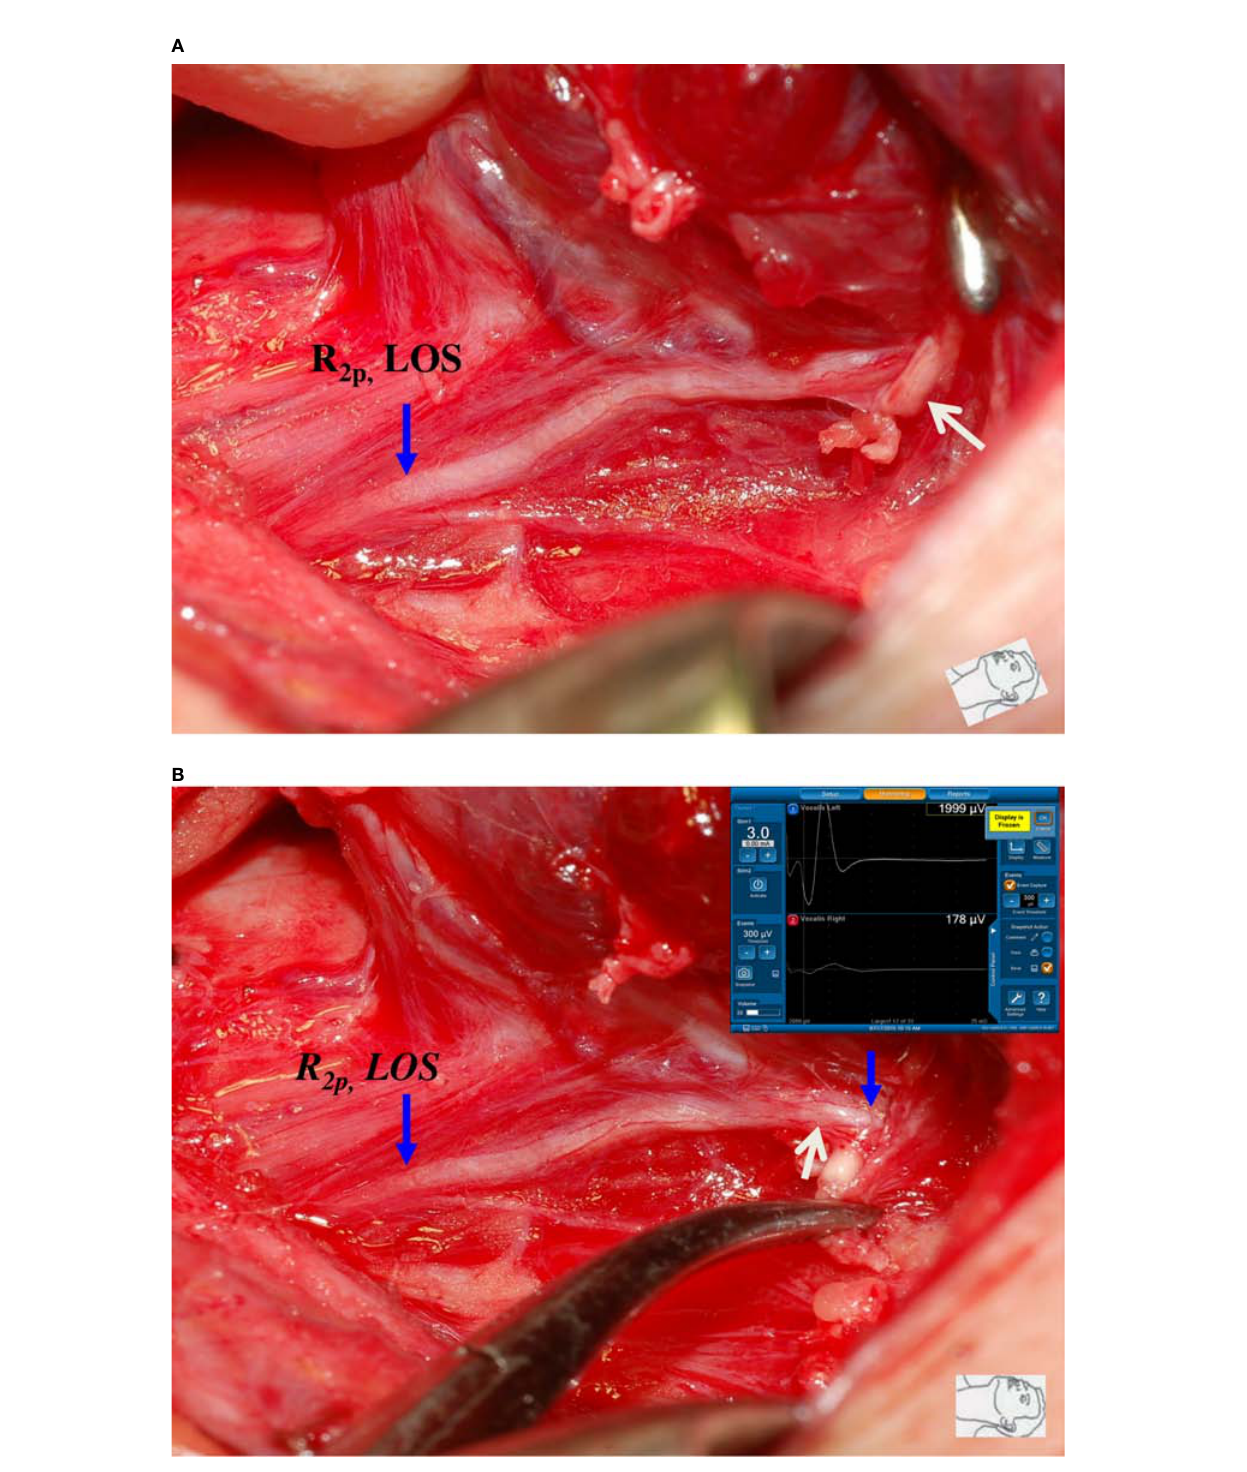
FIGURE 2 | A case of type 1 complete LOS. (A) The R 2p signal was lost, and a small artery (white arrow) was found to be intertwined with the RLN at the region of Berry ’ s ligament. (B) After dissecting the intertwined vessel from the RLN, R 2d signal showed 1999 µV and R 2p signal showed complete LOS, a disrupted point of nerve conduction (white arrow) was detected. This was a type 1 LOS and the patient had temporary vocal cord